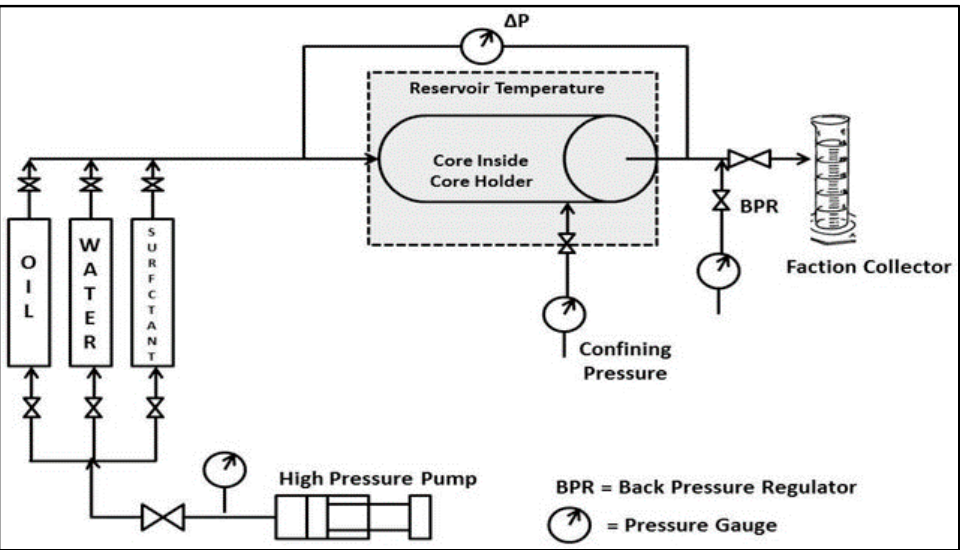
Figure 2. Coreflooding Setup.